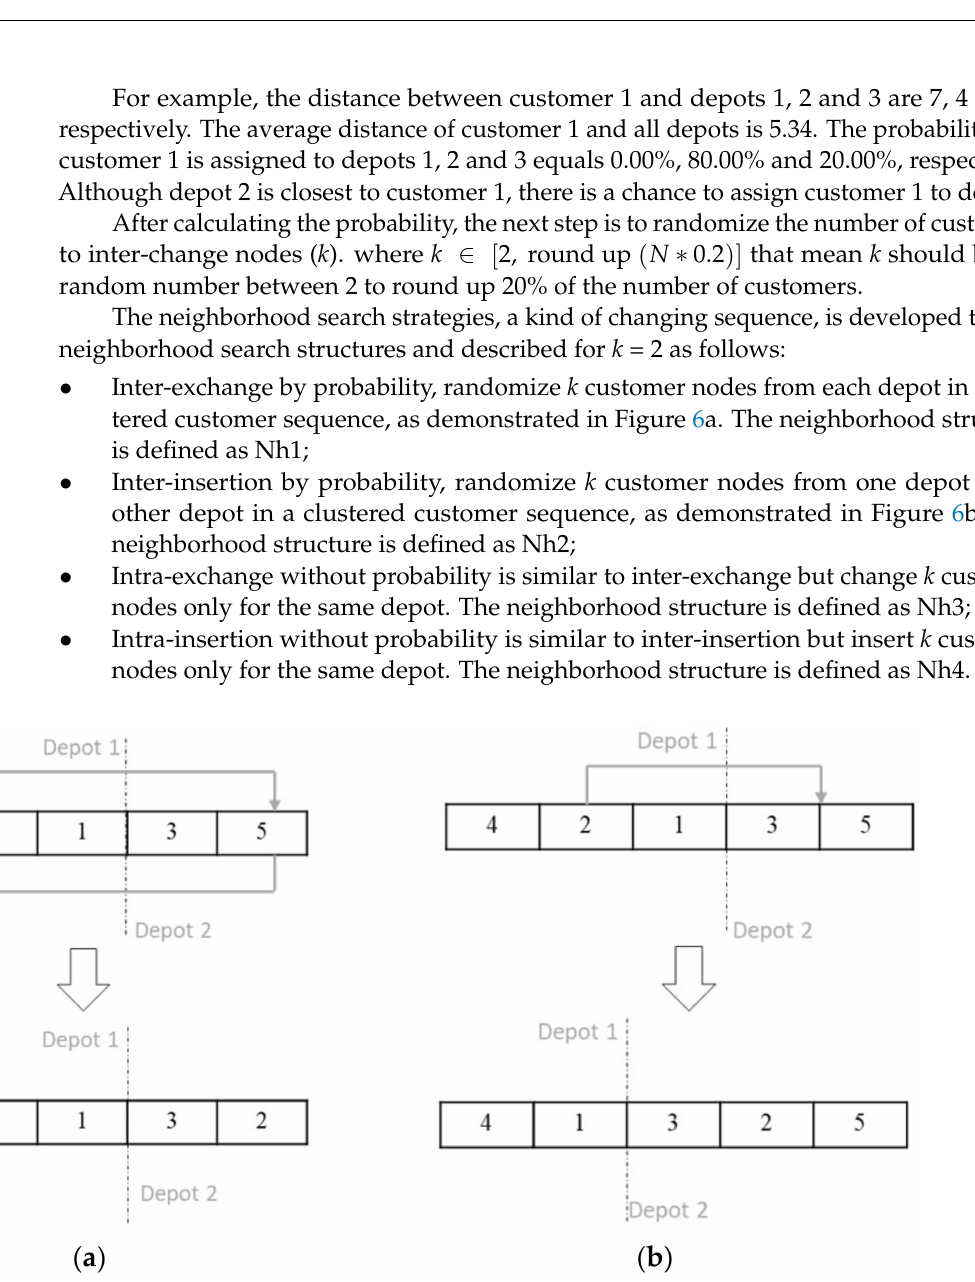
Figure 6. Methods of neighborhood search. ( a ) Inter-exchange; ( b ) Inter-insertion